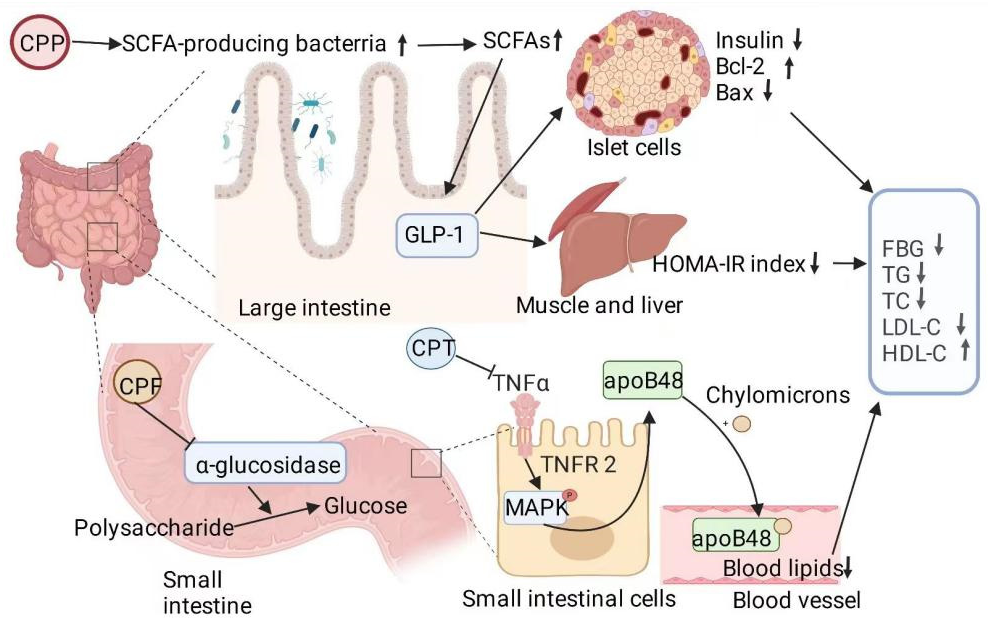
Figure 4. The mechanism of action of Cyclocarya paliurus extract with respect to lowering blood glucose and lipid levels through intestinal metabolism. ↑ : increase; ↓ : decline.